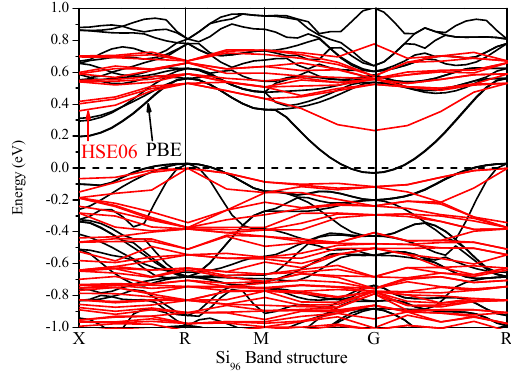
Figure 4. Electronic band structure using Perdew, Burke and Ernzerrof (PBE) and Heyd–Scuseria–Ernzerhof (HSE06) of Si 96 .